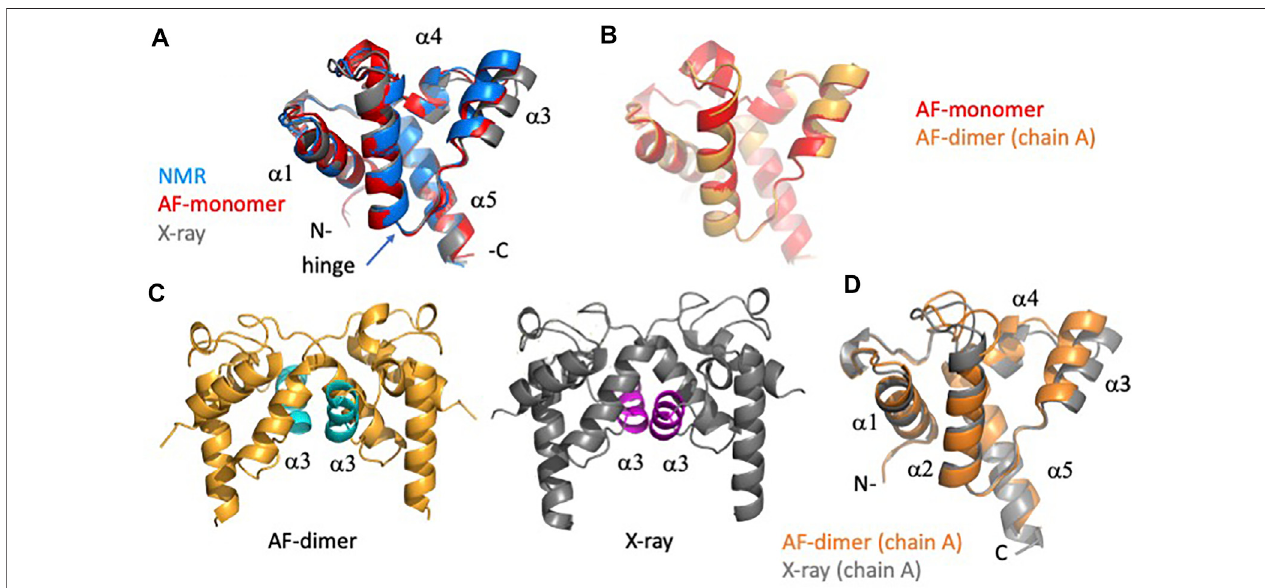
FIGURE 7 | Detailed comparison of solution NMR, X-ray crystal, and AF models of target RpR324. (A) Backbone ribbon representation of solution NMR structure of RpR324 (medoid conformer from PDB ID 2LPK, apo AcpXL) (blue), overlayed withAlphaFoldstructurecalculated asmonomer (red), and X-ray crystal structure (PDB ID3LMO)(grey). (B) OverlayofAlphaFoldstructurecalculatedasmonomer (red)and calculatedasadimer (orange)usingAlphaFold-multimersoftware. (C) Comparison of (left) AlphaFold dimer (orange) with α 3 helix highlighted in cyan (left), with (right) X-ray crystal structure (grey), with α 3 helix highlighted in magenta. (D) Overlay of protomers from dimeric AlphaFold model (orange) with X-ray crystal structure (grey), illustrating the signi fi cant difference in orientation of α 3 helix.